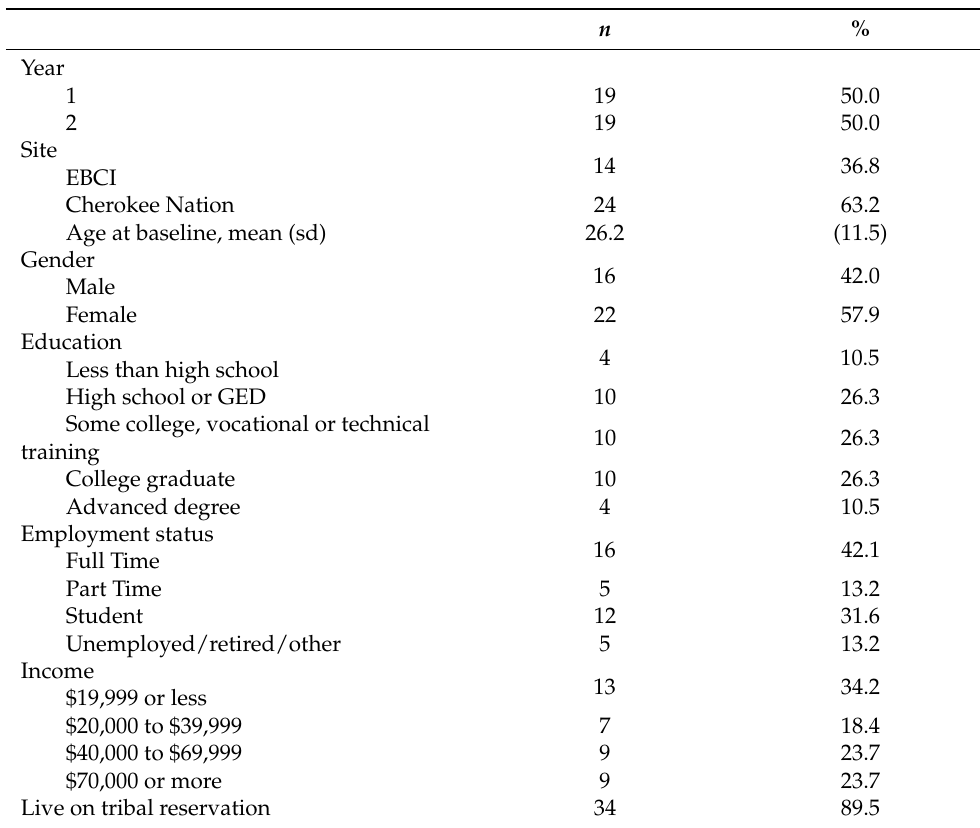
Table 2. Sample demographics ( n =